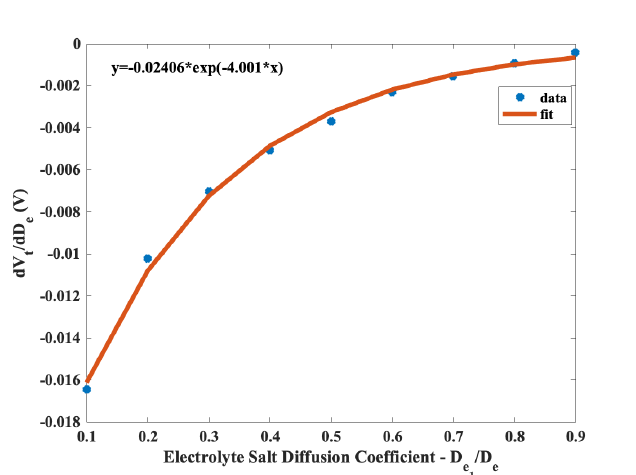
Figure 6. Change of terminal voltage to transference number vs. electrolyte salt diffusion